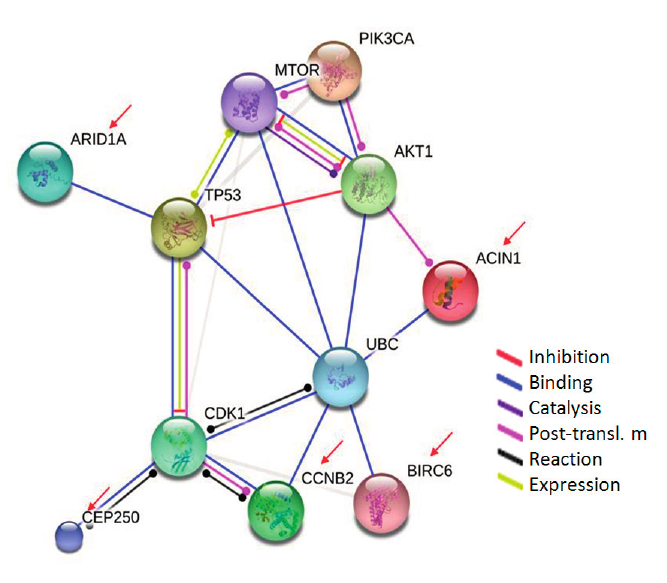
Figure 4. The protein–protein interaction pathways are illustrated. Proteins identified in this study are marked by arrows. The SF-CSNPs can turn on the ubiquitin pathway, which is responsible for the proliferation and is required for survival of the majority of